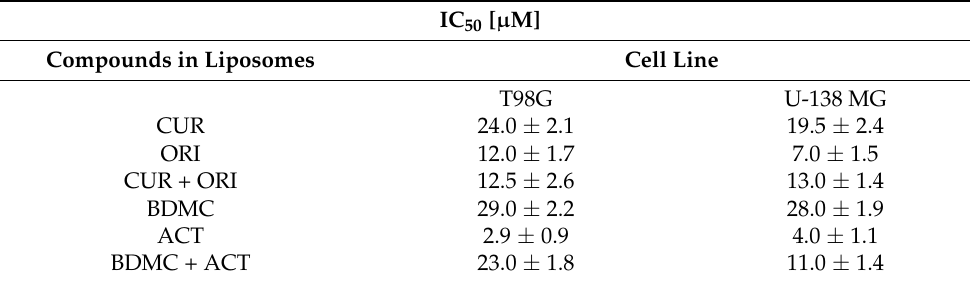
Table 5. IC 50 values of CUR, ORI, BDMC, ACT, and their combinations in liposomes. Data are expressed as the mean ± SD from three independent experiments.